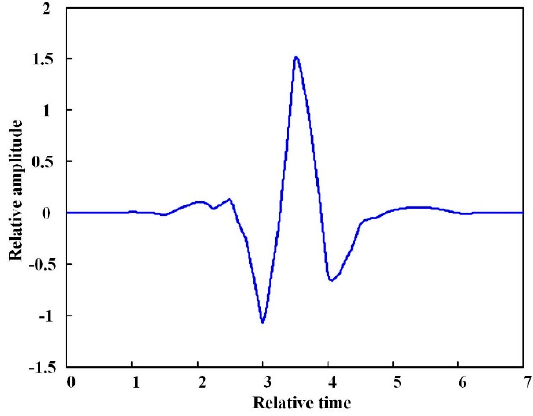
Figure 6. Typical waveform of sym4 wavelet.